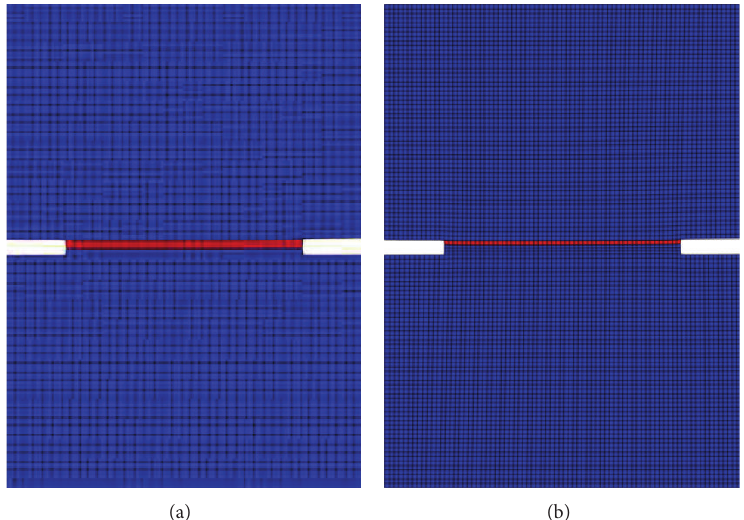
Figure 2: Comparison of the damage distribution of a double-notched edge specimen numerical tensile tests using the local BCJ model for two different mesh sizes, coarse (a) and fine (b) meshes. Note the localization of the damage in a layer of width one element size for the two meshes.